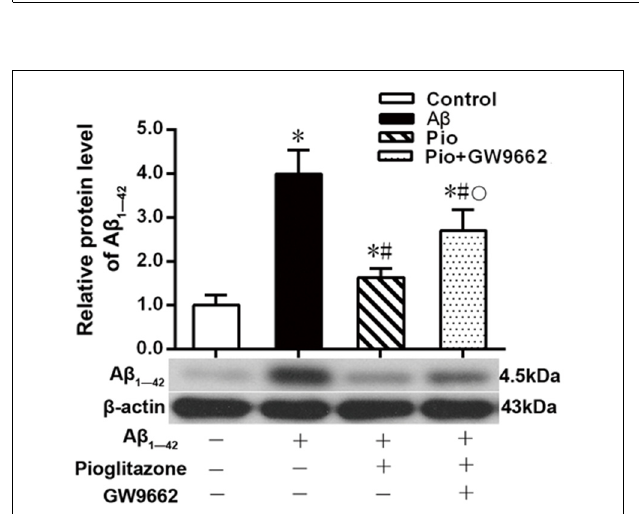
FIGURE 4 | Effects of pioglitazone on the levels of A β 1–42 in AD model neurons after CDK5 silencing. n = 6 wells per group. ∗ P < 0.05 compared to the A β